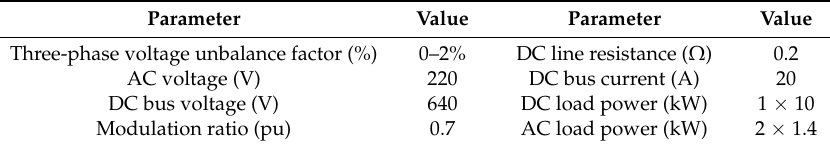
Table 4. Parameters of the bipolar double-ended DC distribution model.